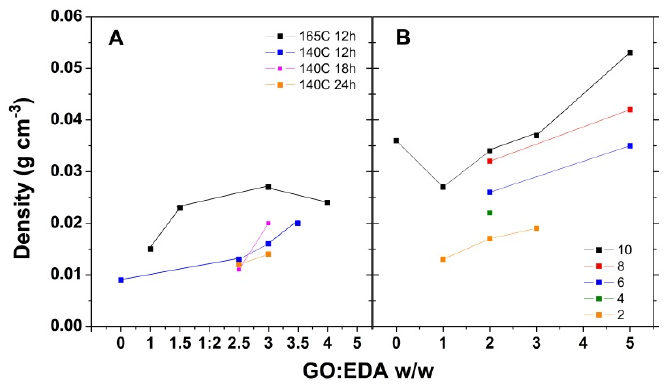
Figure 2. Aerogel density evolution by the HT approach ( A ) and LT one ( B ) as a function of GO/EDA ratio for varying GO concentration (mg·mL − 1 ).